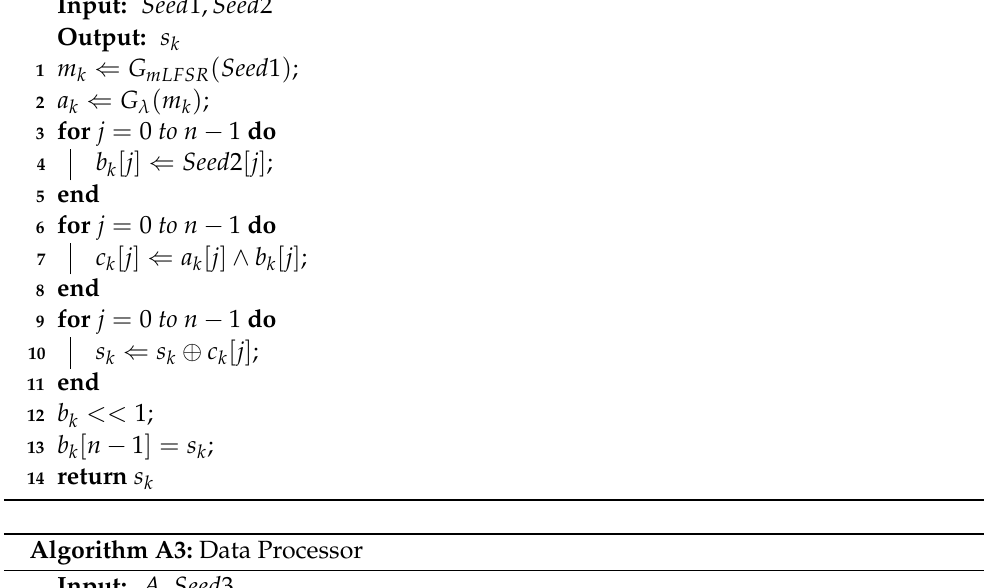
Algorithm A2: The Nonlinear Pseudorandom Sequence Generator